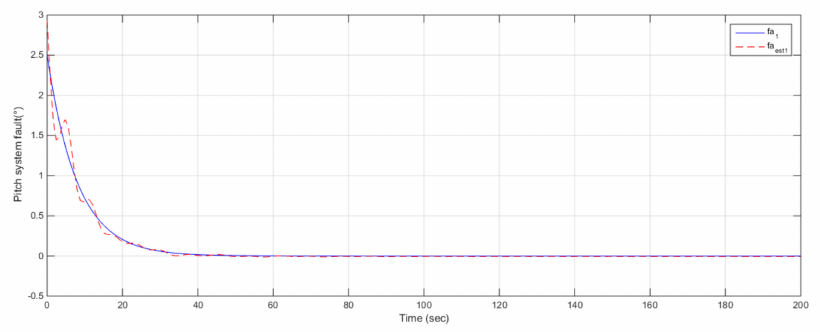
Figure 11. Pitch system fault and its estimation.